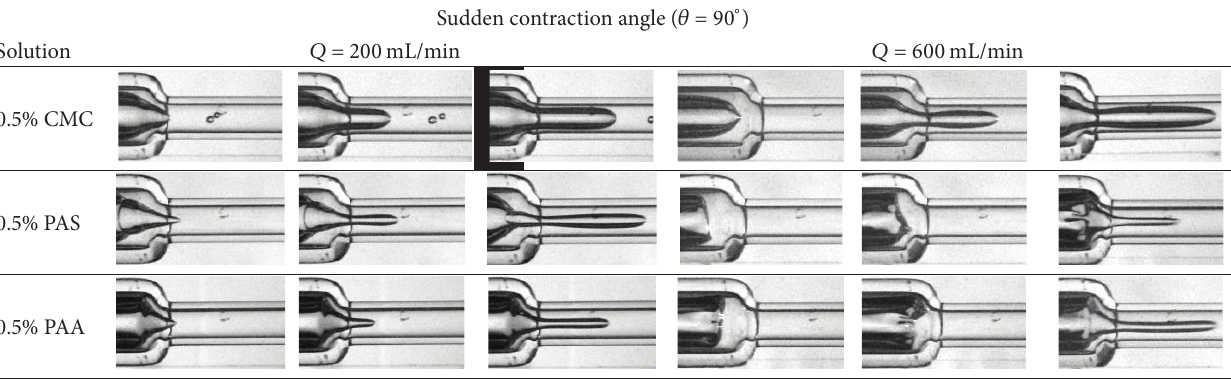
Table 4: Evolution of bubble contours for sudden contraction angle 𝜃 = 90 ∘